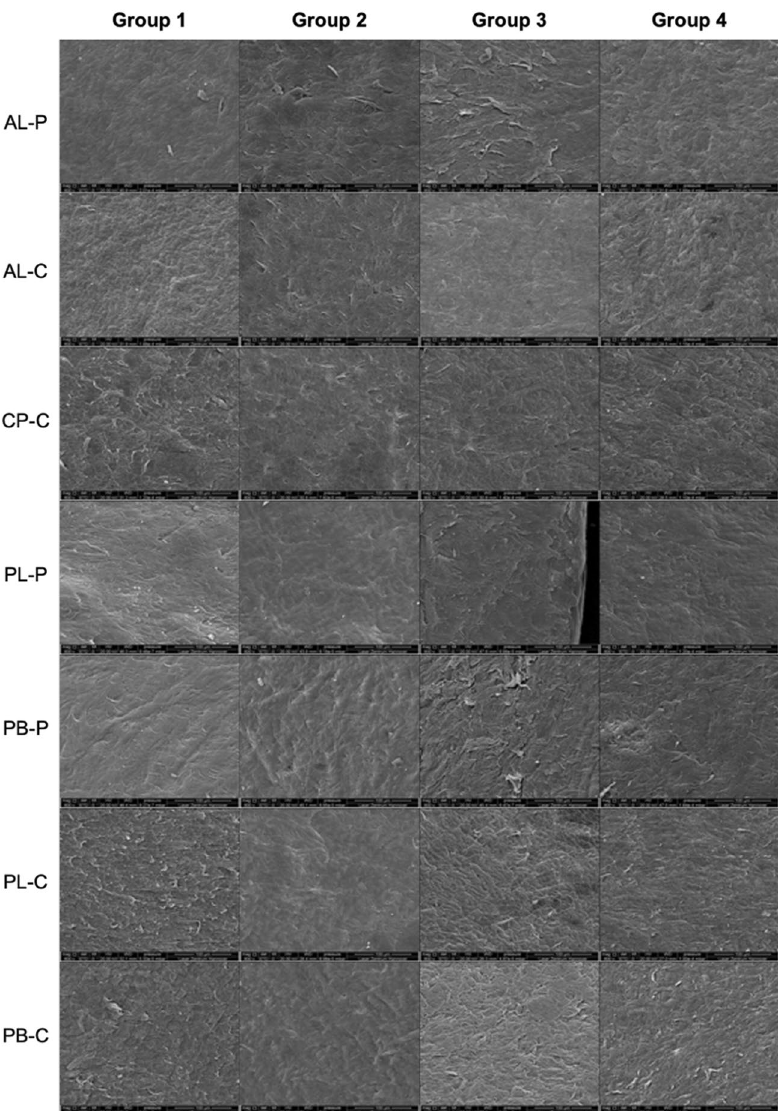
− 5.0D treatment) and group 4 (laser power:64% for − 5.0D treatment). The pictures show the scans of anterior lenticular surface periphery & centre, anterior cap centre, posterior lenticular periphery & centre and posterior stromal base centre and periphery. (AL-P = anterior lenticule surface periphery; AL-C = anterior lenticule surface centre; CP-C = Centre of cap’s posterior surface; PL-P = posterior lenticule surface periphery; PB-P = posterior stroma base periphery; PL-C = posterior lenticule surface centre; PB-C = posterior stroma base